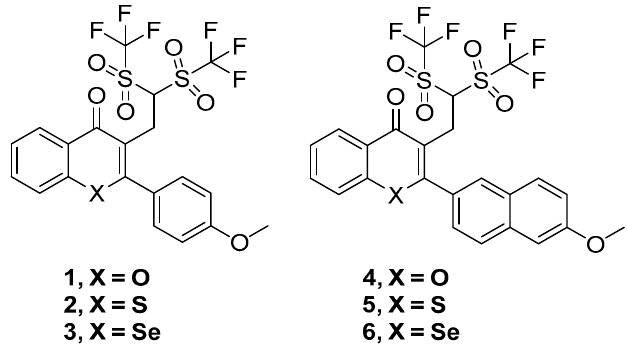
Figure 1. Structures of the flavone derivatives ( 1 – 3 ) and the bioisosteric analogues of flavones ( 4 – 6 ).